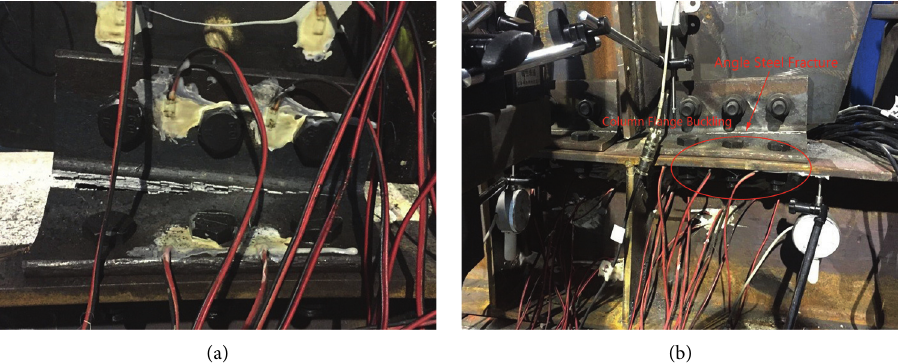
Figure 5: Fracture form of SJB-1. (a) Gusset angle steel fracture (87mm). (b) Angle steel fracture +column flange buckling (87 mm).